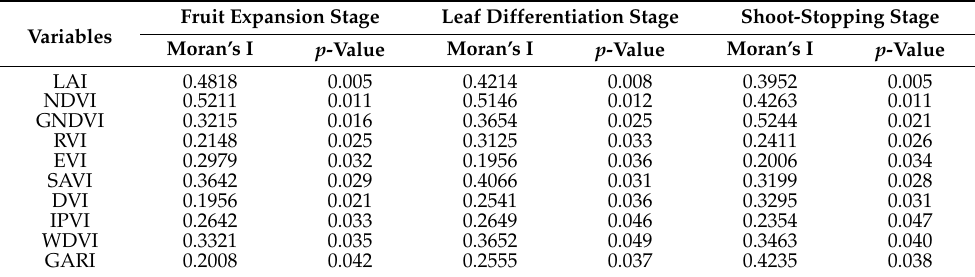
Table 8. Results of the autocorrelation analysis of the spatial